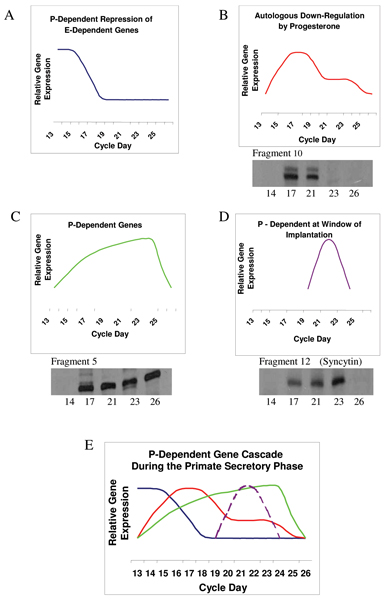
A schematic representation together with examples of relative gene expression patterns in the rhesus endometrium during the secretory phase [56]. A) progesterone (P) repression of estradiol (E)-dependent genes. B) autologous down-regulation of P-dependent genes e.g. fragment 10. C) P-induction of genes during the secretory phase e.g. fragment 5. D) P-induction of gene expression during the window of receptivity e.g. fragment 12, syncytin. E) a composite cascade of gene expression patterns A-D. The associated panel (B-D) for each fragment shows the relevant temporal portion of the gel following PCR analyses.